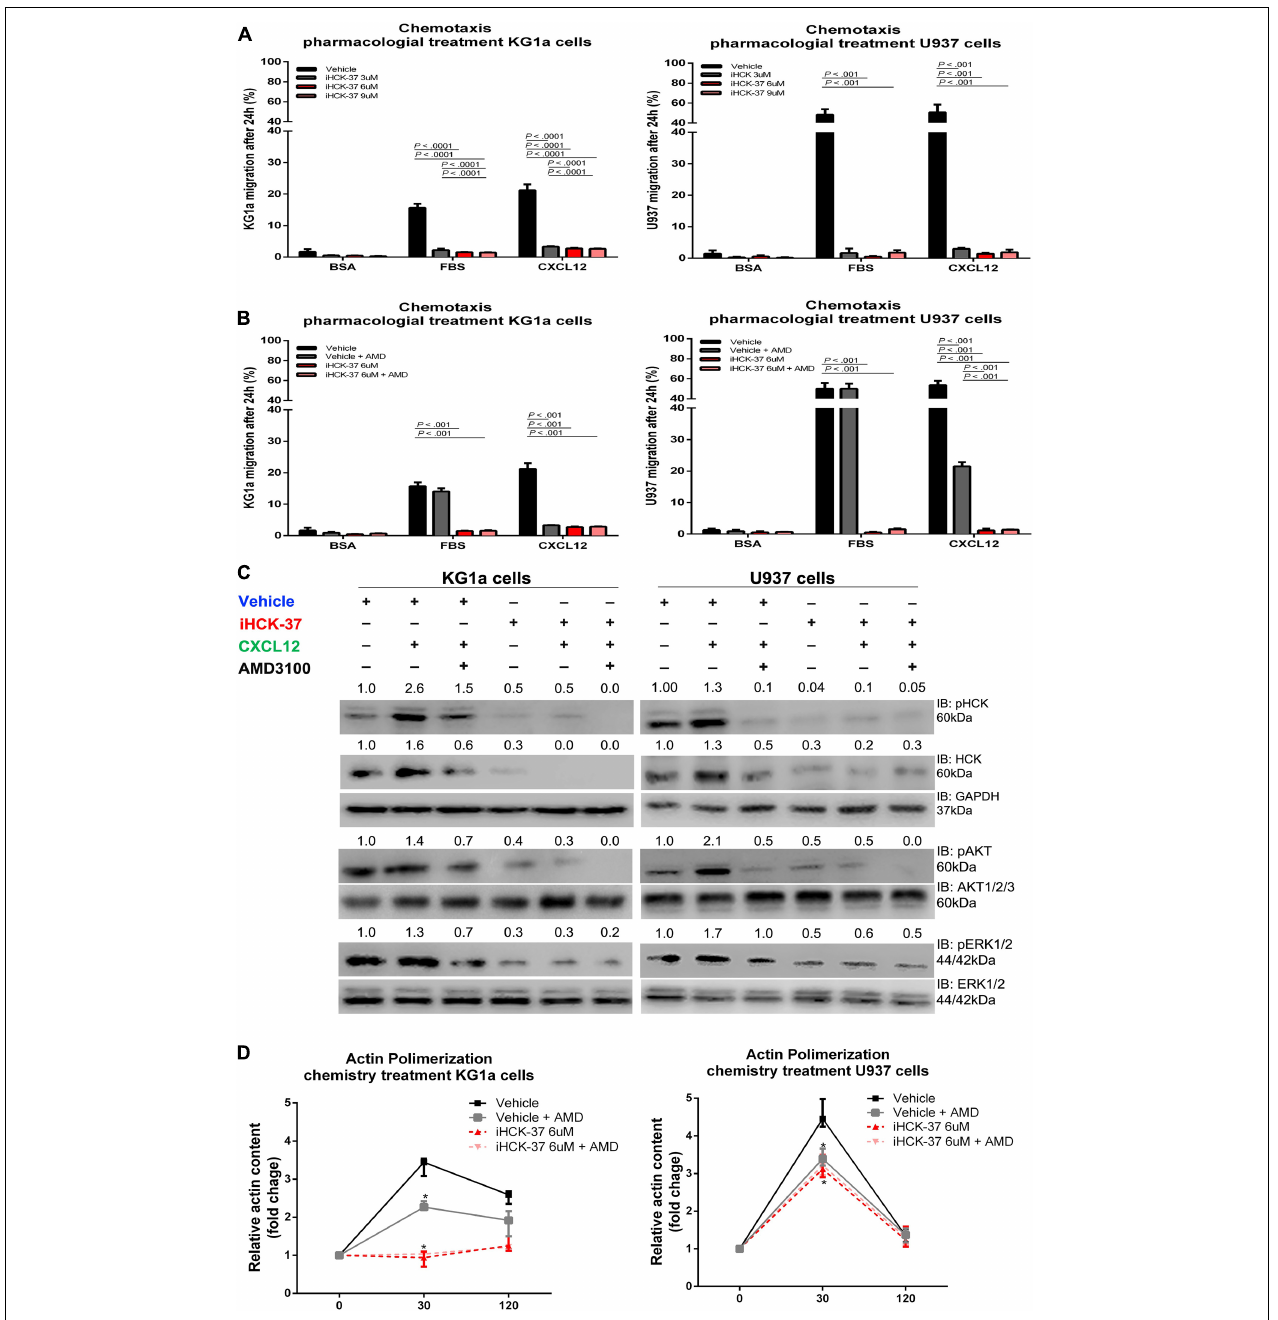
FIGURE 3 | Selective HCK inhibitor reduces CXCR4/PI3K and MAPK signaling pathways activation and decreases cell chemotaxis and actin polymerization. (A) Chemotaxis assays in iHCK-37 (3, 6, and 9 µ M) treated or not cells and allowed to migrate in Transwell chambers. (B) Chemotaxis assays in iHCK-37 (6 µ M) treated or not cells, in the presence or absence of CXCR4 antagonist (1.25 µ g/mL of AMD3100). Leukemia cell lines were pretreated or not with iHCK-37 for 48 h and allowed to migrate in Transwell chambers toward CXCL12 (100 ng/mL), using 10% FBS-containing media as the positive control and 0.5% BSA-containing medium as the negative control. After 24 h, the migrated cells on the lower chamber membrane were counted. (C) Western blotting analysis of total iHCK-37 treated (6 µ M) or not cell extracts, stimulated of not with CXCL12 (100 ng/mL) and in the presence and absence of a CXCR4 antagonist (AMD3100). Membranes were blotted with antibodies against HCK (60 kDa), pAKT (60 kDa), AKT (60 kDa), pERK1/2 (44/42 kDa), ERK1/2 (44/42 kDa), or GAPDH (37 kDa), as a control for equal sample loading, and developed with the ECL Western Blotting. (D) F-actin intracellular levels measured by flow cytometry in iHCK-37 treated or not cells. Leukemia cell lines were pretreated or not with iHCK-37 (6 µ M) for 48 h and then stimulated with CXCL12 (300 ng/mL) for 30 or 120 s, in the presence and absence of a CXCR4 antagonist (AMD3100), stained with phalloidin, and MFI was quantified by flow cytometry. Data indicate fold increase in F-actin content following stimulation with CXCL12. Results are shown as mean ± standard deviation of duplicate replicate and are representative of, at least, 4 independent experiments; Mann–Whitney test.